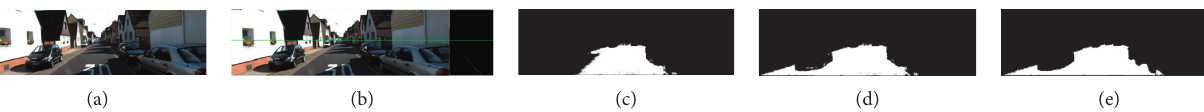
Figure 5: Road detection algorithm. (a) Original image. (b) Horizon position. (c) Road initial contour. (d) Road point completion. (e) Detection